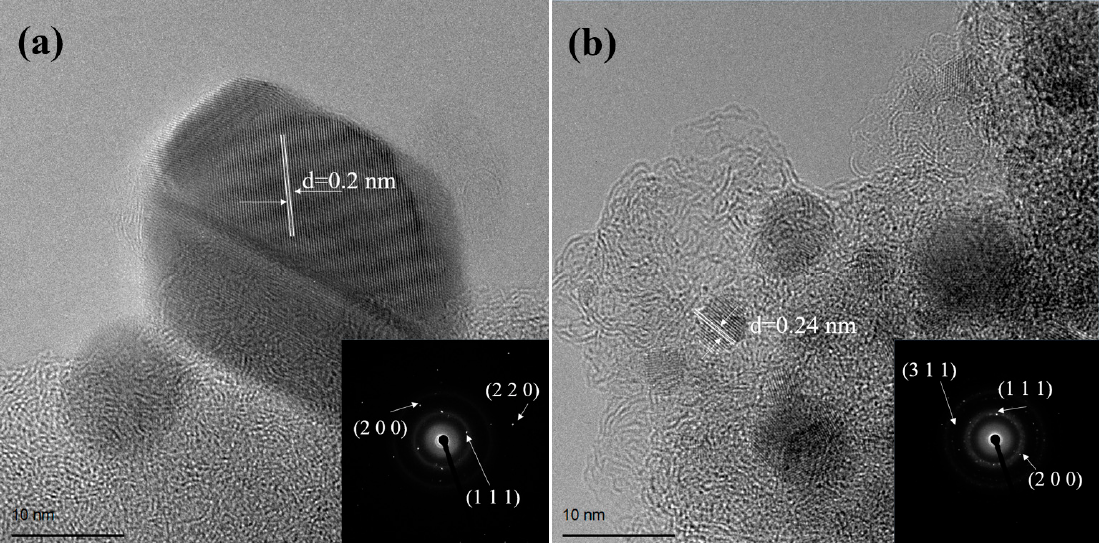
Figure 1. High-resolution transmission electron microscopy images of ( a ) Pd/C and ( b ) Rh/C, after reduction, respectively. Insert: electron diffraction patterns (see Figure S1 in Supporting Information for size-distribution diagrams). Arrows indicate the location of planes.